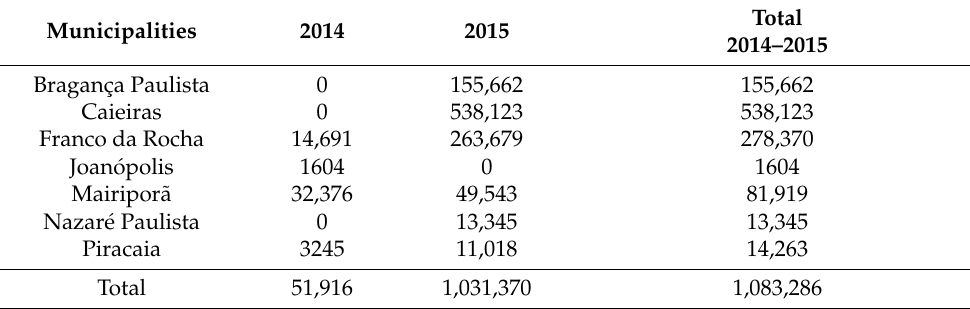
Table 6. Industry GVA loss by municipalities located in CWSS (BRL